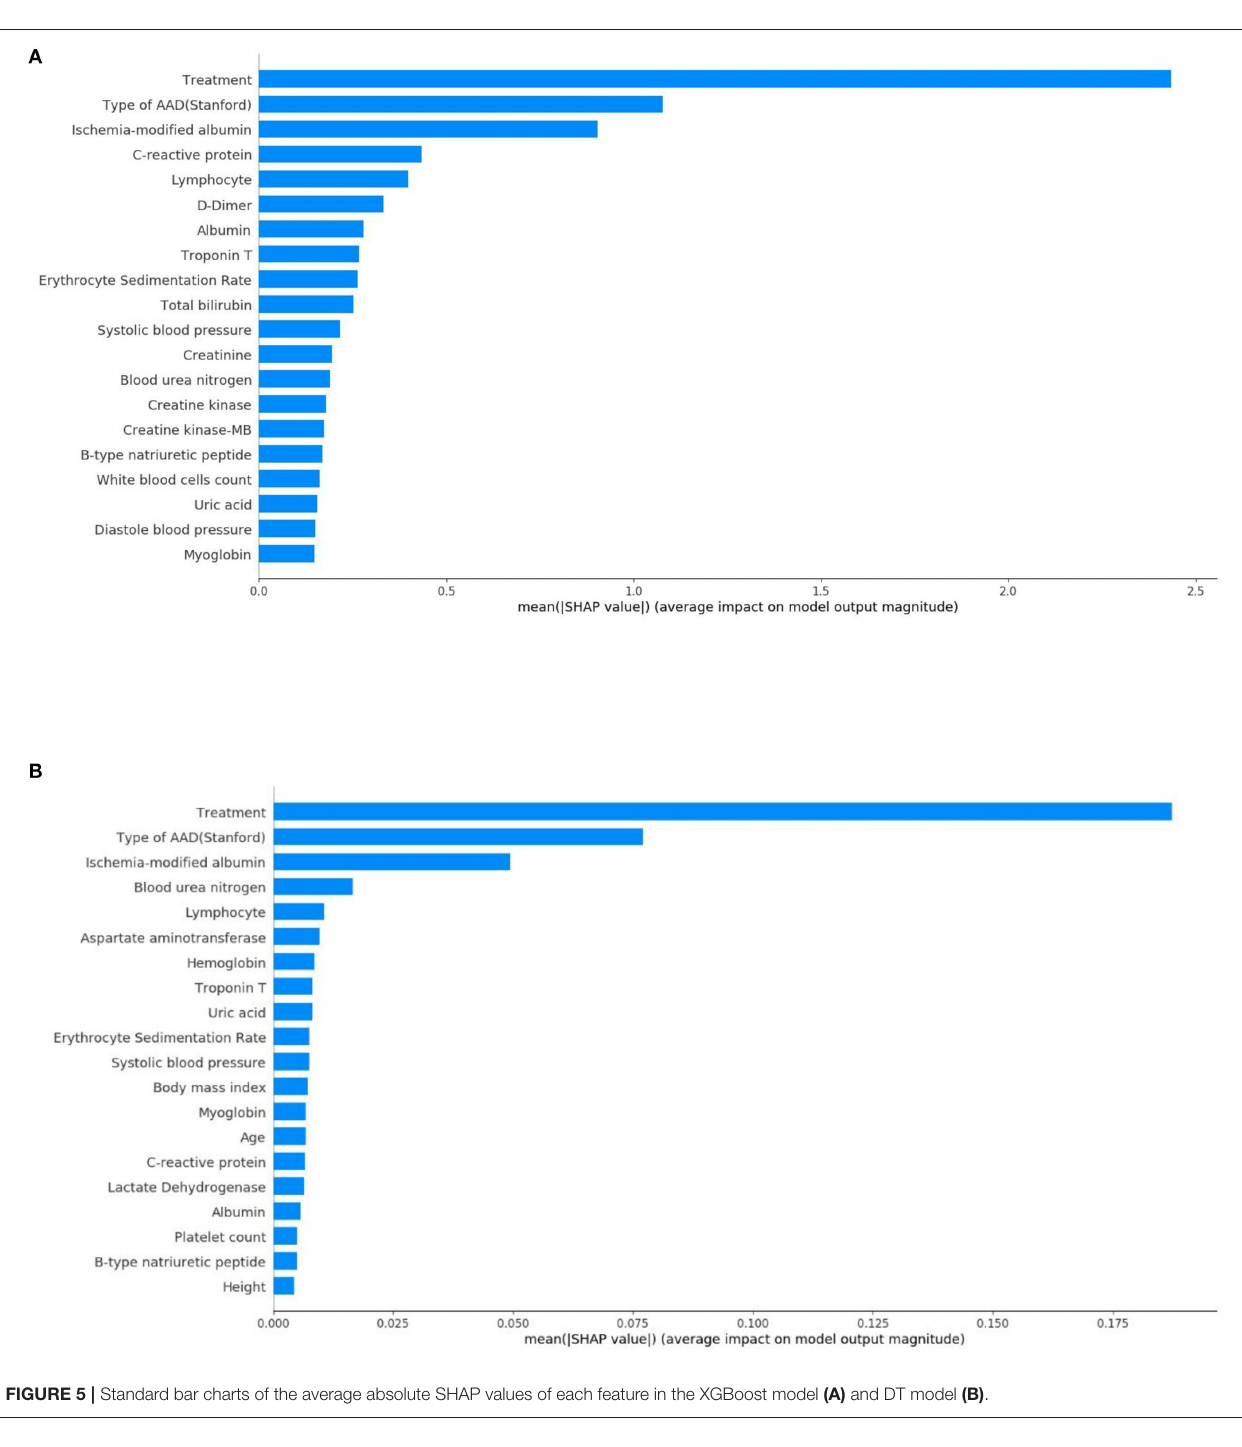
patients with AAD are treatment strategy, type of AAD, and ischemia-modified albumin